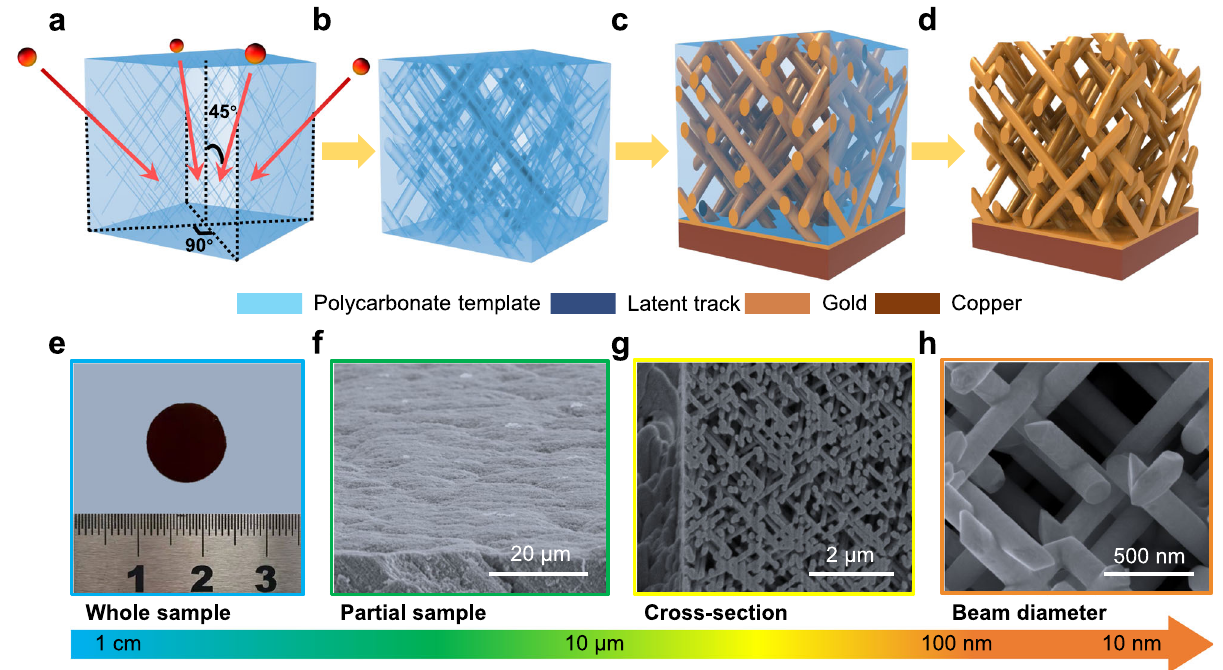
Fig. 1 | Fabrication of gold quasi-BCC nanolattice and morphological char- acterization. a Ion irradiation at multiple directions. b Chemical etching of ion tracks. c Electrochemical deposition of gold. d Free-standing quasi-BCC nano- lattice. e Photograph of a quasi-BCC nanolattice sample. f Low-magni fi cation